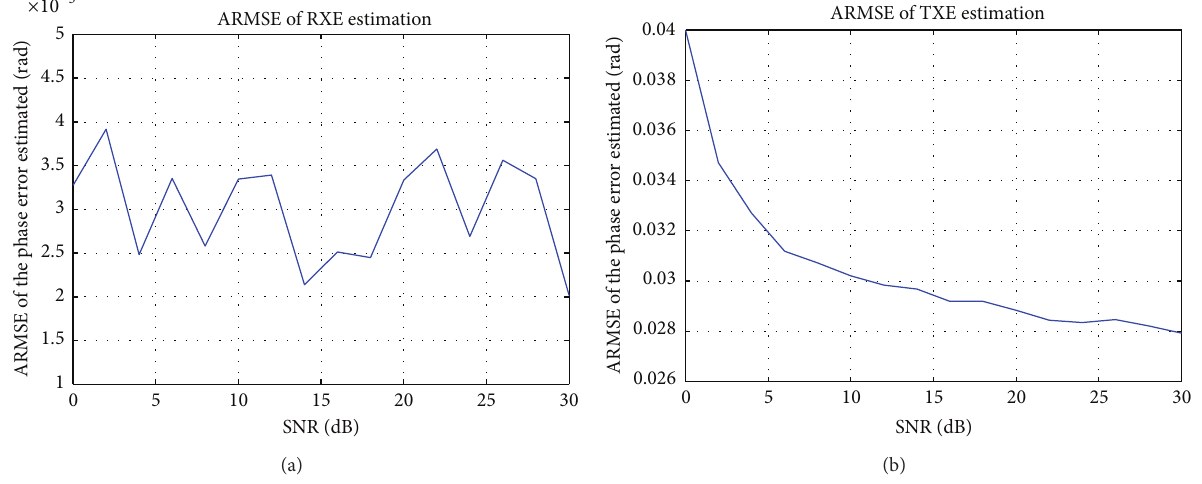
Figure 7: Results of Monte Carlo simulation. (a) Results of RXE estimation. (b) Results of TXE estimation.